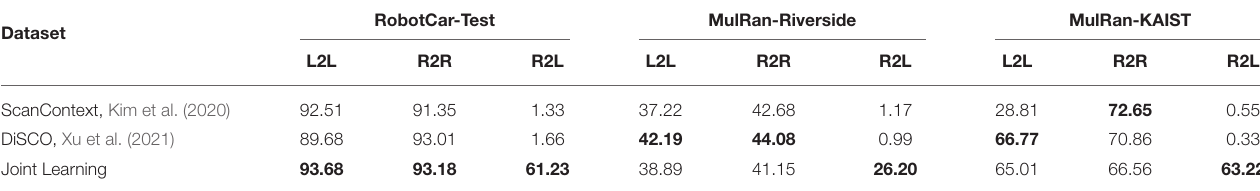
TABLE 3 | Recall@1 (%) of multi-session place recognition. Dataset